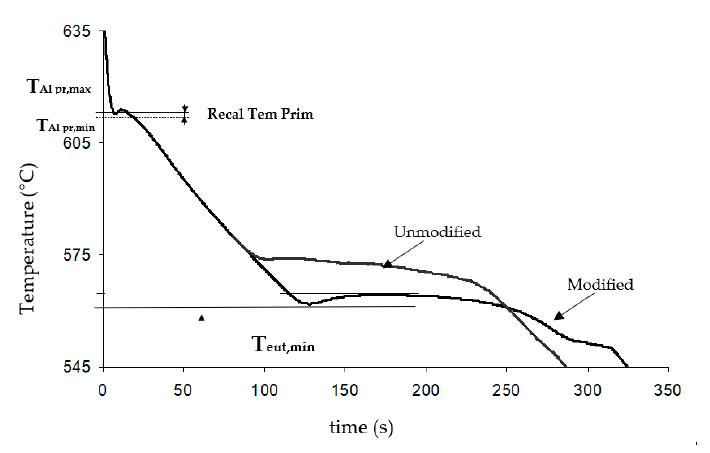
Figure 2. Example of the cooling curve with definitions of the critical parameters.